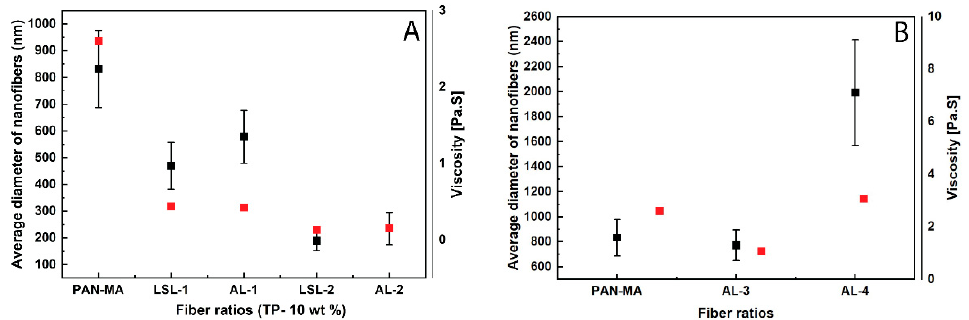
Figure 4. Correlations obtained between PAN-MA/lignin electrospun nanofibers’ diameter with polymer solution viscosity at 10 s − 1 for ( A ) fibers of different lignin types and blend ratios at a total 10 wt % and ( B ) fibers at higher polymer content of 12 wt % (AL-3) and 20 wt % (AL-4). [Points with error bars represent nanofiber diameters].